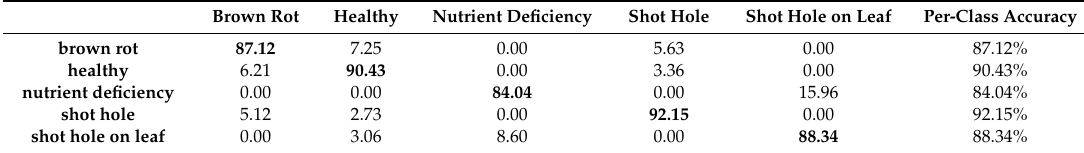
Table 8. Disease detection performance on unseen samples outside the test